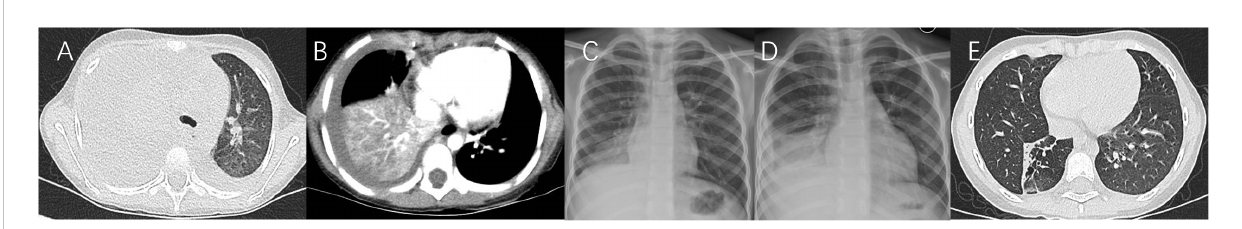
FIGURE 4 Case 4. Chest imaging showed right high-density lesions and left pleural effusion ( A , day 8), right necrotizing pneumonia and pleural effusion ( B , day 17), right high-density lesions ( C , day 23; D, day 33), right pleural effusion (D) , and right localized atelectasis and bronchiectasia ( E , 20 months after illness onset).